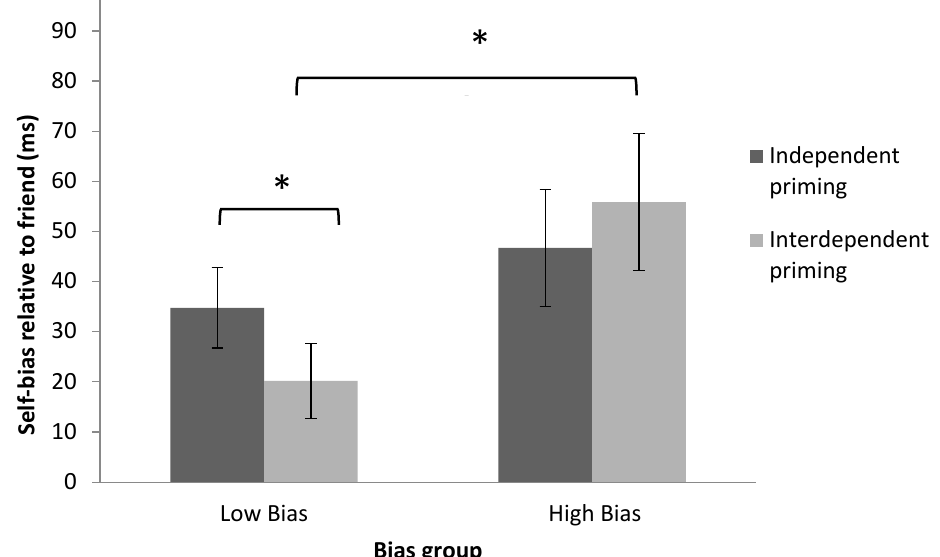
Figure 4. Decomposition of the significant interaction between priming, shape ‐ label association and bias group using the self ‐ bias relative to friend (calculated friend RT—self RT) in Experiment 1. Mixed design ANOVA revealed a significant interaction between the priming and bias group, and the paired ‐ sample t ‐ test revealed a significant difference of priming in the low ‐ bias group. Error bars represent one standard errors. Significant results are marked with “*”.